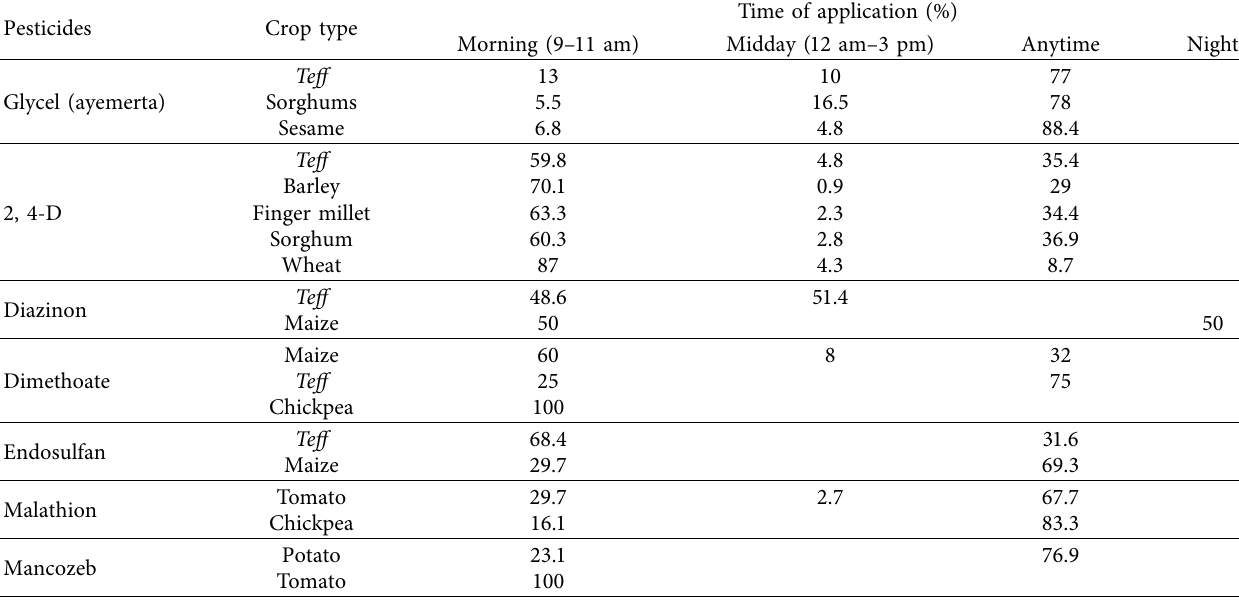
Table 9: Time of the day that the respondents were applying pesticides on their crops. Pesticides